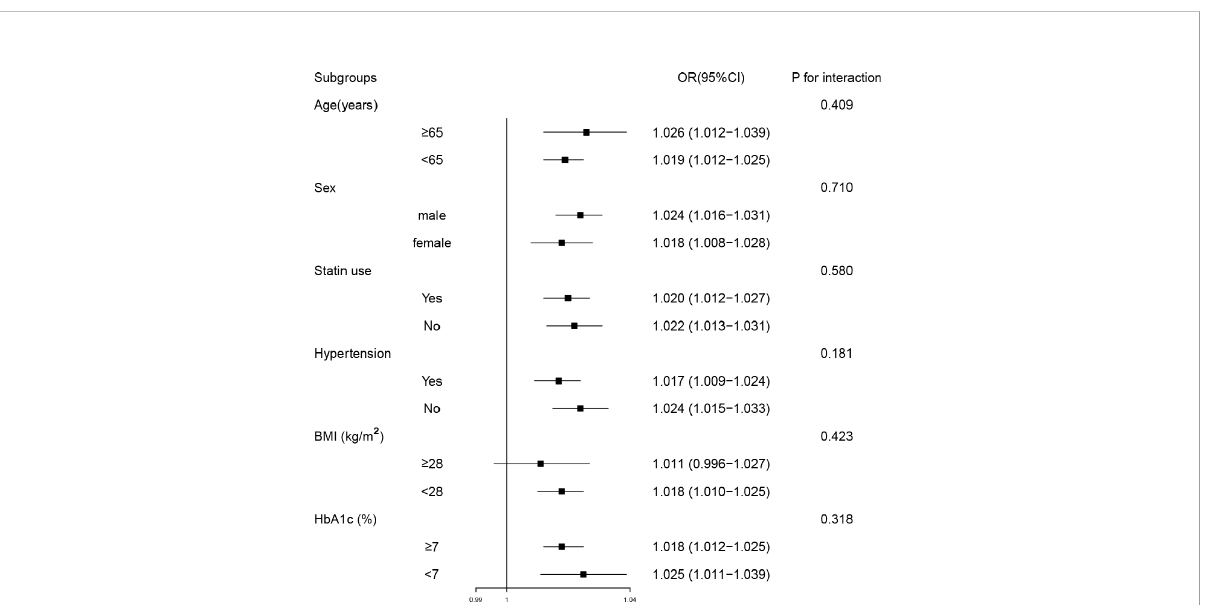
FIGURE 2 Subgroup analyses of the associations between Chinese visceral adiposity index and metabolic-associated fatty liver disease. Model was adjusted for diastolic blood pressure, duration of diabetes, glycated hemoglobin, hemoglobin, alanine transaminase, aspartate aminotransferase, gamma-glutamyl transferase, albumin, blood urea nitrogen, total cholesterol, low-density lipoprotein cholesterol, statin use and metformin use. Subgroup variable was excluded from the model. OR, odds ratio; CI, con fi dence interval; BMI, body mass index; HbA1c, glycated